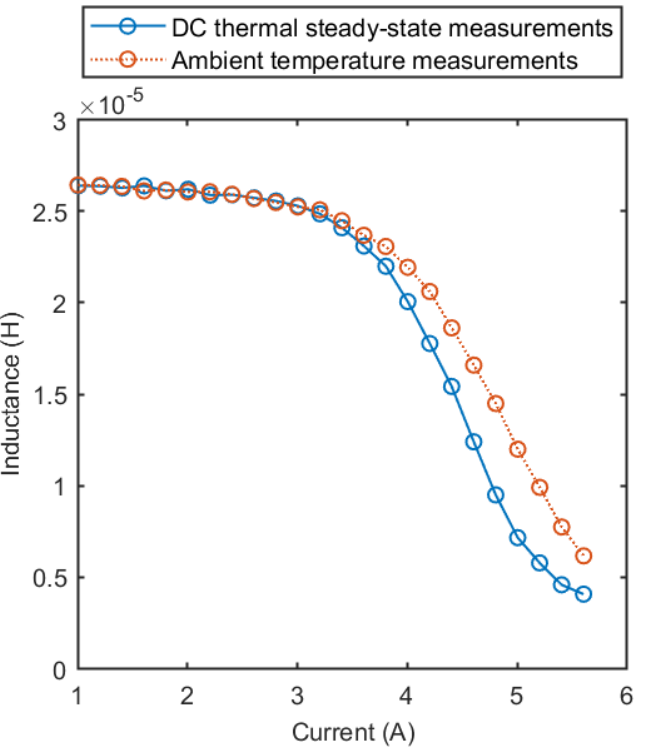
Figure 3. Experimental DC thermal steady-state differential inductance curve for the Coilcraft MSS1260T-273 inductor compared to the curve obtained from ambient temperature measurements (25 °C).